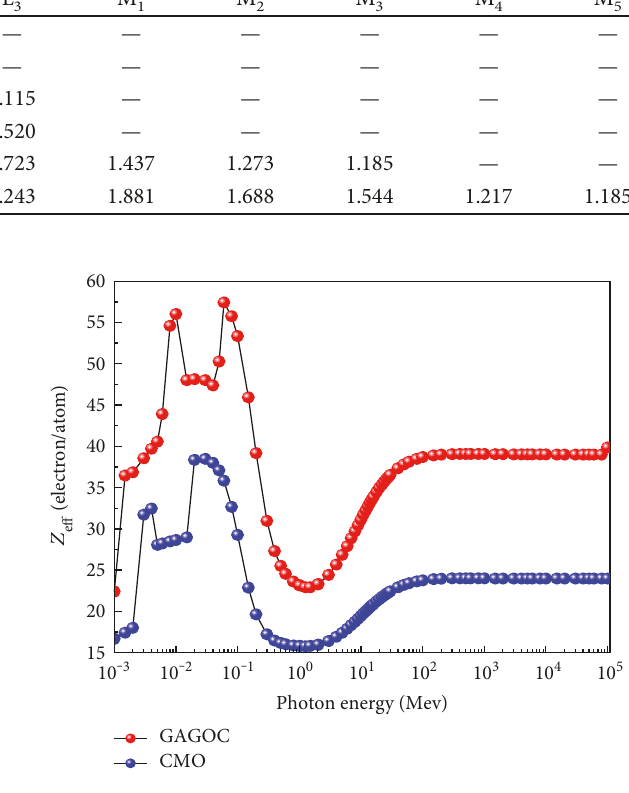
Figure 5: Variation of e ff ective atomic number ( Z of photon energy in the range of 1 keV to 100 GeV for GAGOC and CMO. Table 2: E ff ective atomic numbers of the GAGOC and CMO scintillators corresponding to the K-absorption edge energies of the constituent